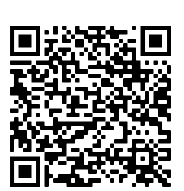
Video 2 - Intraoperative view using cardiopulmonary bypass.